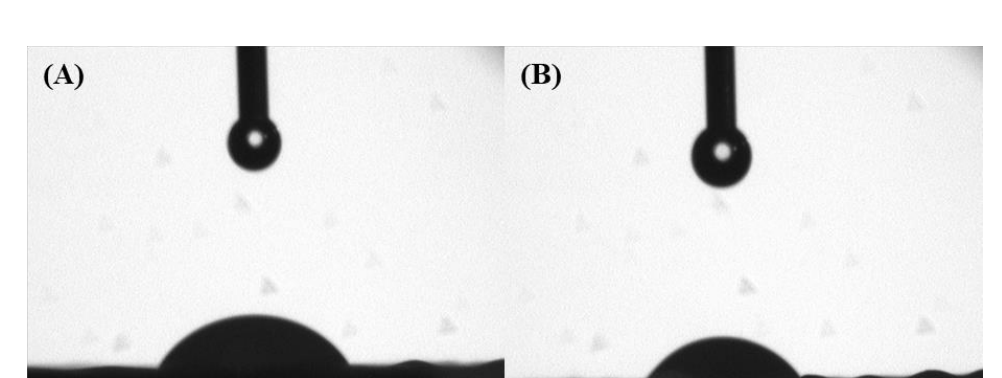
Figure 6. The water drop test on a PCL scaffold filament at 0 s ( A ) and 20 s ( B ). Table 1. The geometric characteristics of the scaffolds.